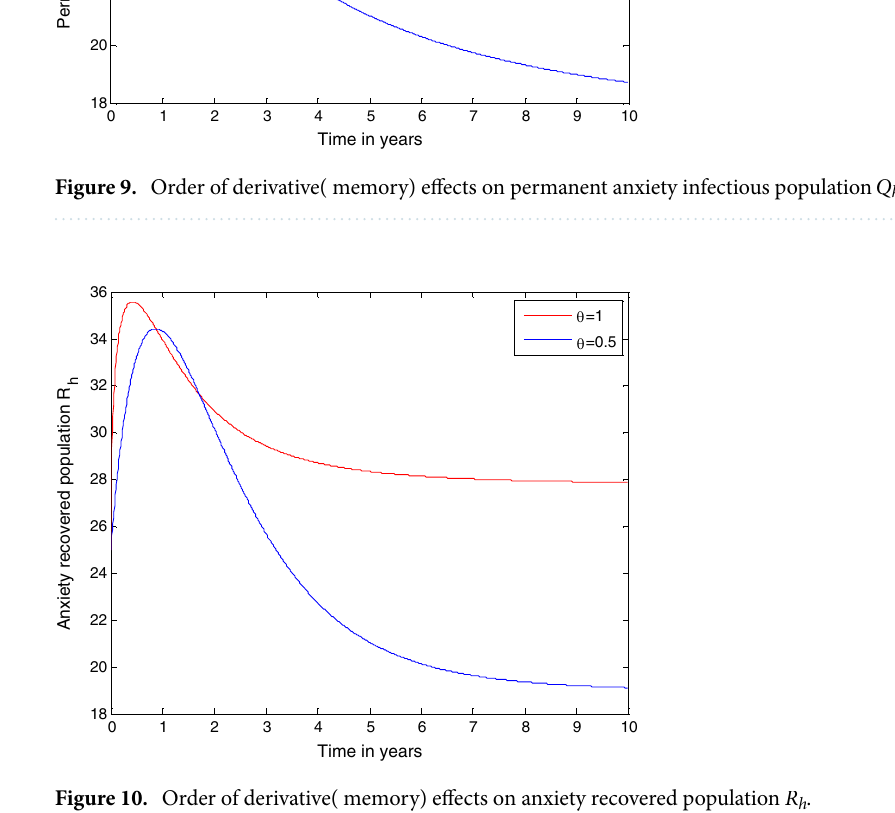
Figure 10. Order of derivative( memory) effects on anxiety recovered population R h